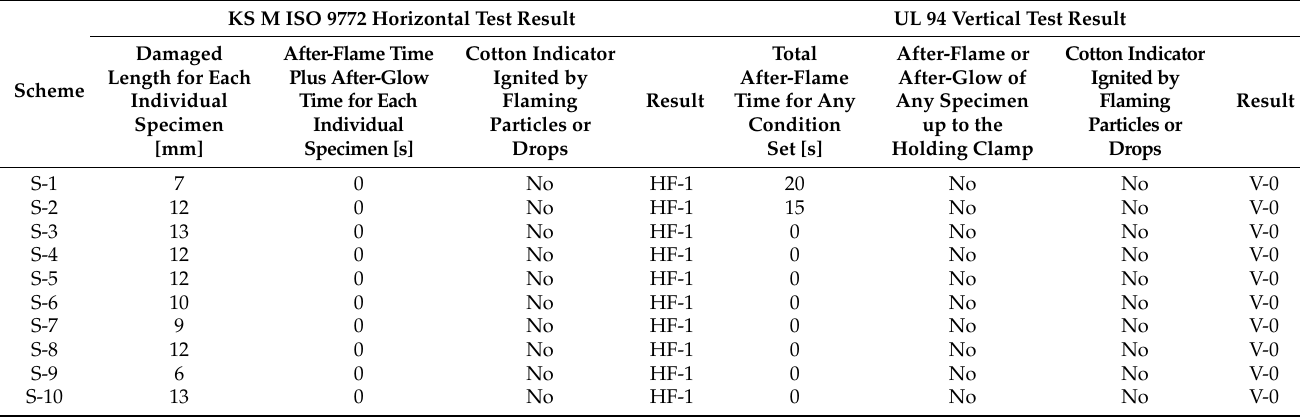
Table 4. Horizontal and vertical burning test results of